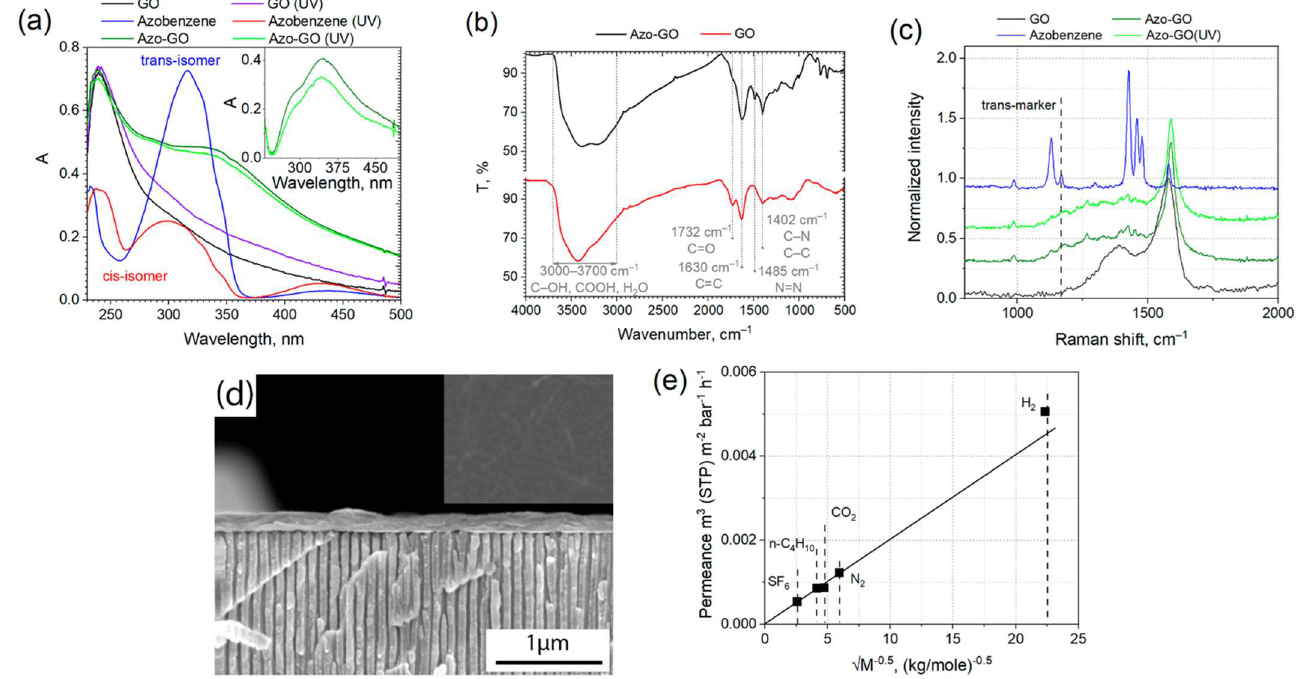
Figure 1. UV-Vis optical absorption spectra of azobenzene, GO, and azo-GO prior and after UV exposure (325 nm, 10 mW) for 20 min ( a ). The difference spectra for azo-GO are provided on the inset. IR spectra of GO and azo-GO samples ( b ). The spectra of pure azobenzene compounds and their physical mixtures with GO are provided in Supplementary Information S4. Raman spectra for azo-GO membrane collected prior and after UV exposure (325 nm, 10 mW) for 20 min ( c ). The spectra of azobenzene and pure graphene oxide obtained in the same conditions are provided for reference. The position of trans-azobenzene marker is given in [33] (c). Cross-sectional and top-view (inset) scanning electron microscopy images of Azo-GO composite membrane ( d ). The inset has the same magnification. Gas permeance of Azo-GO composite membrane vs. reverse square root of molecular weight, indicating Knudsen diffusion mechanism of the permeance of the gases ( e ).